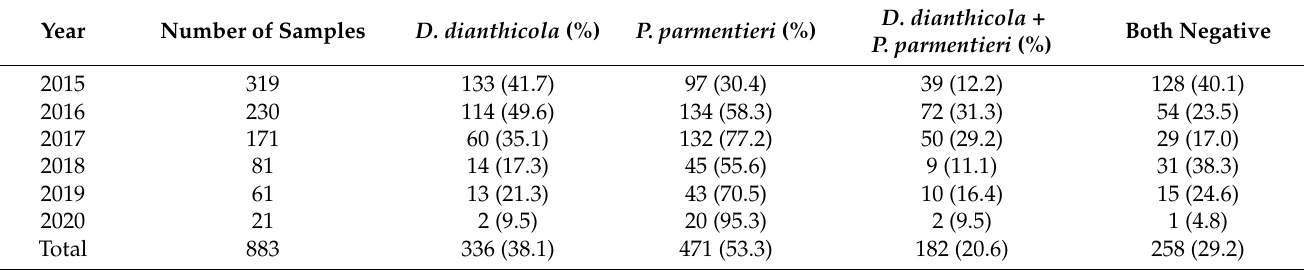
Table 1. Detection of Dickeya and Pectobacterium spp. in symptomatic potato stems or tubers using polymerase chain reaction (PCR).